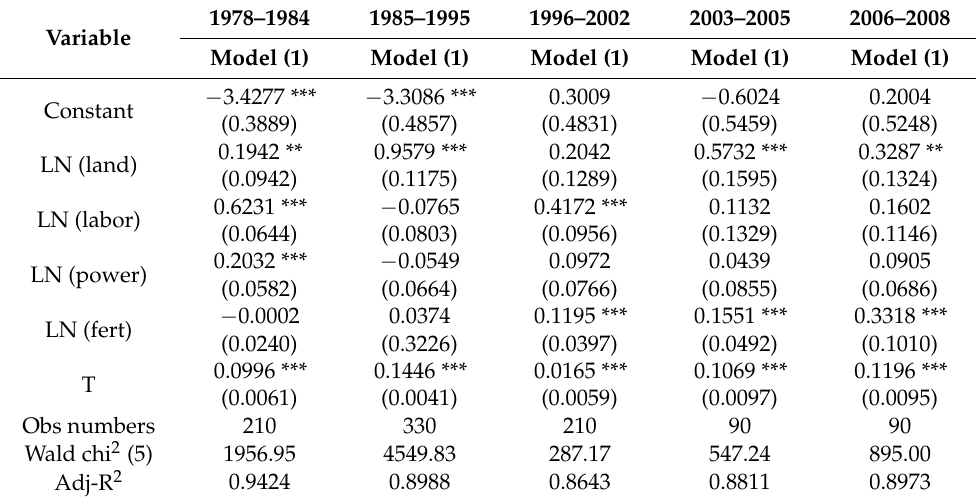
Table 2. Accounting for agricultural output: Production function.